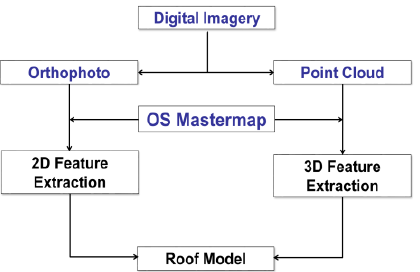
Figure 2. Workflow for extraction of roof